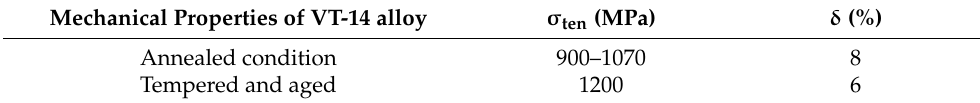
Table 4. Mechanical properties of VT-14 alloy.